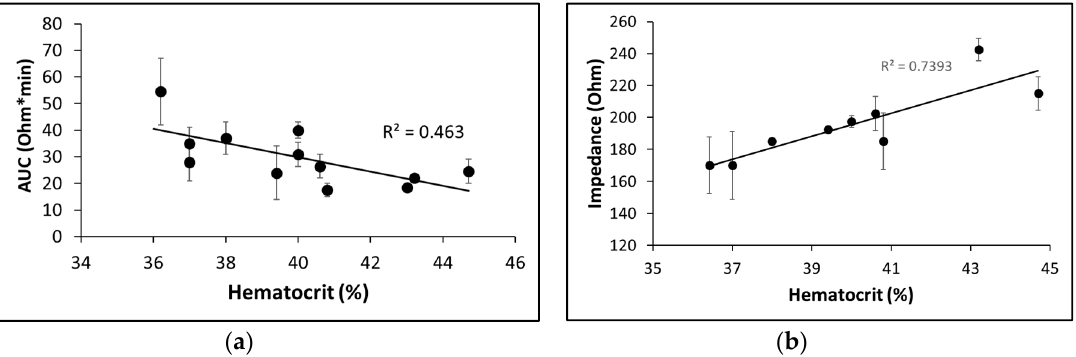
Figure 7. The influence of hematocrit on ADP-induced platelet aggregation in hirudin-anticoagulated whole blood. ( a ) Platelet aggregation is not significantly affected by hematocrit within physiological range 36%–45%; ( b ) The baseline impedance strongly corelates with hematocrit: AUC—area under the curve. A total of 20 µ M ADP was used to induce platelet aggregation. Data from 12 ( a ) or 9 ( b ) independent experiments using blood samples from different individuals are reported. Mean ± SD as error bars are indicated.